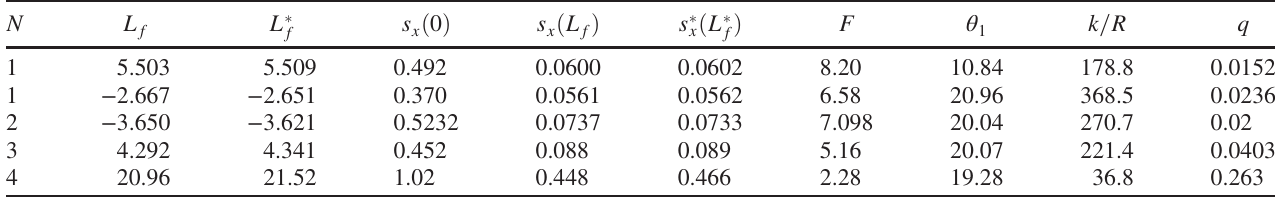
TABLE I. The measured characteristics of focusing (defocusing) crystal deflectors. N is the crystal number, L f , s x ð L f Þ and L (cid:3) f s (cid:3) x ð L (cid:3) f Þ are the focal lengths and rms sizes (at the focal point), which were obtained with the help of Eqs. (1) – (5) and Eqs. (8) – (11), respectively, s ð 0 Þ is the initial rms size at l ¼ 0 , F ¼ s x are measured in m and mm respectively, angle θ 1 is measured in μ rad, and k=R is measured in μ rad = mm.